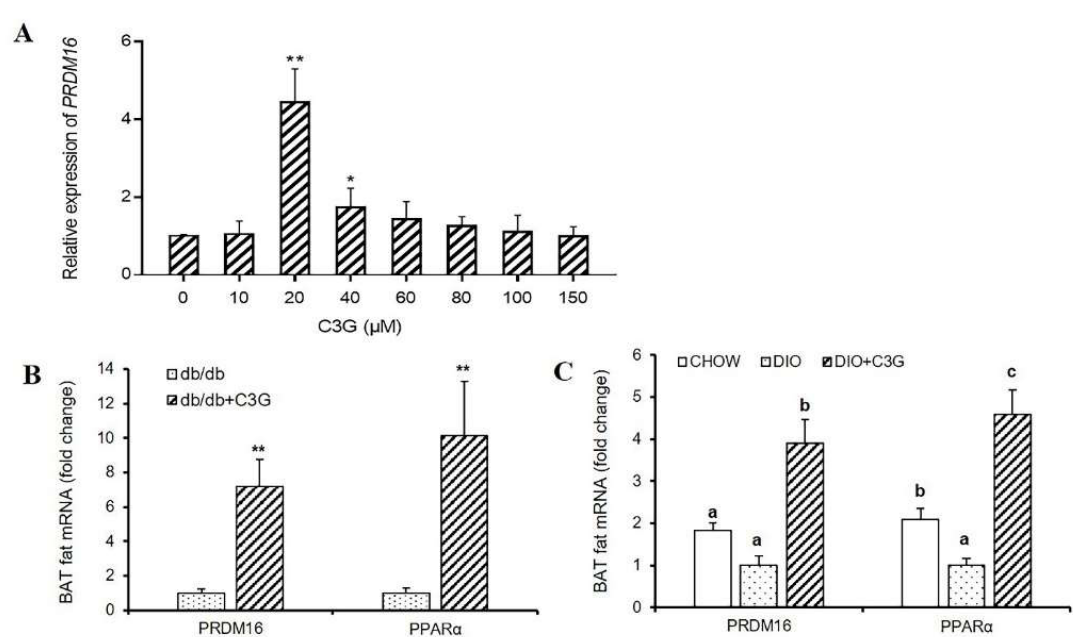
Figure 2. C3G was able to up-regulate the expression of Prdm16 gene both in vitro and vivo. ( A ) Effect of C3G at different concentrations on Prdm16 gene expression in C3H10T12 cells. ( B , C ) Gene expression profile in BAT, real-time PCR analysis of thermogenic-related genes, including Prdm16 , PPAR α in db/db mice model ( B ) and mice with DIO model ( C ) ( n = 6–8). Values represent means SD. Error bars represent SD; mean values with asterisk or different letters are significantly different ( p < 0.05).